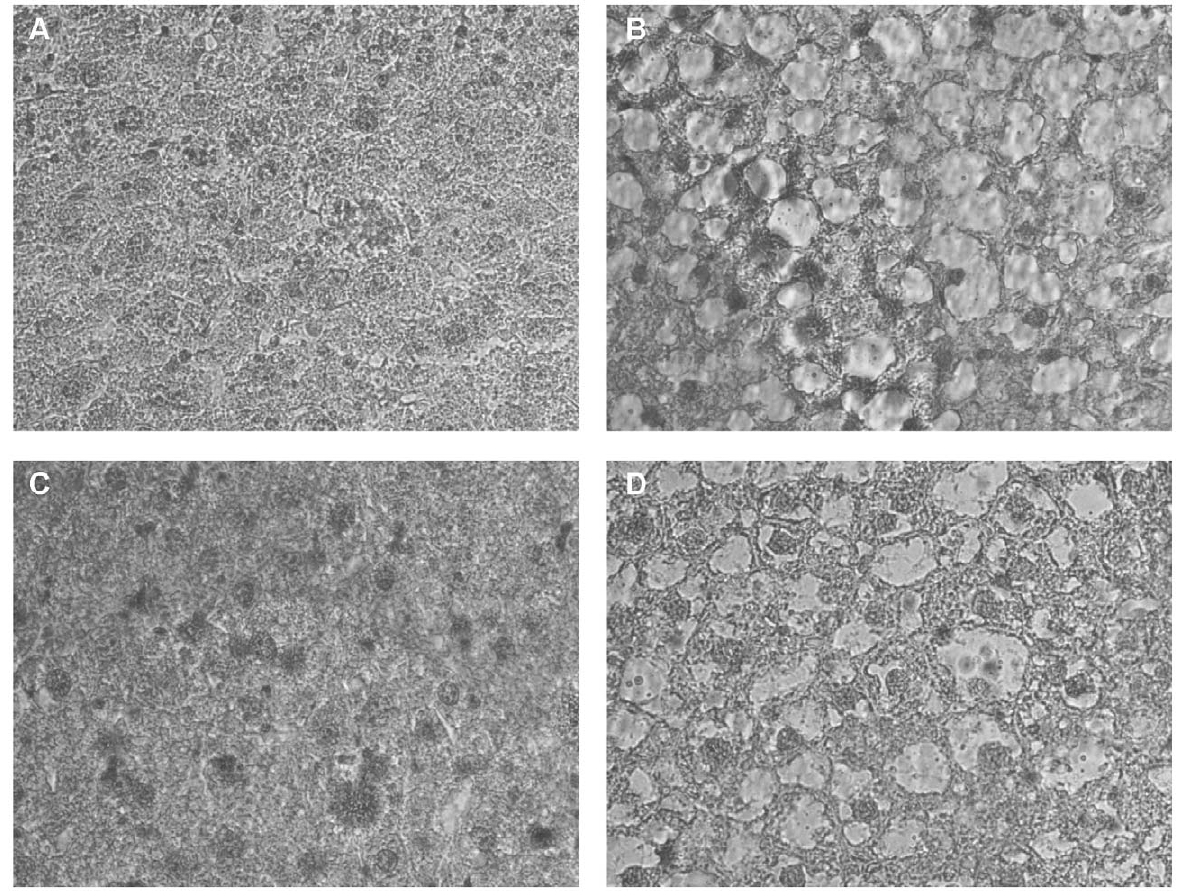
Figure 2. Effect of LAB supplementations on hepatic lipid contents in obese mice. A, RD/RD; B, HFD/HFD-C; C, HFD/HFD-LP28; D, HFD/ HFD-SN13T. Magnification, 6 400.